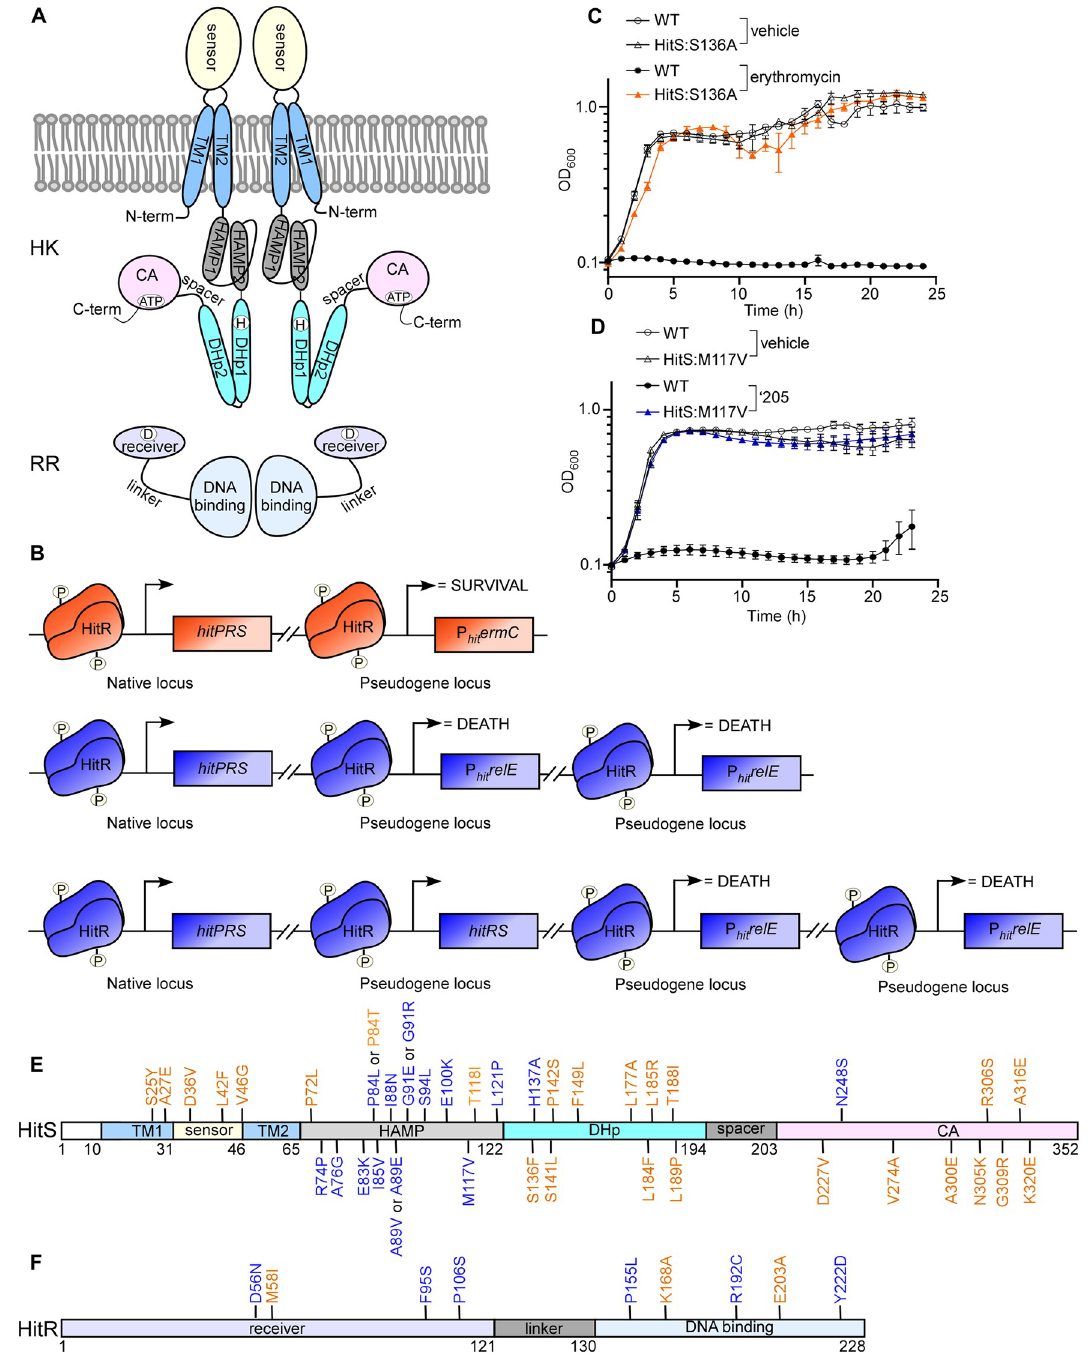
Fig 1. Genetic selection strategies to study HitRS signaling mechanism. (A) Schematics of the modular structure of a prototypical TCS. A classic histidine kinase (HK) consists of five domains: a N-terminal Trans-Membrane domain (TM), a sensor domain, a HAMP domain, a DHp domain, and a CA domain while a response regulator (RR) consists of two domains: a receiver domain and a DNA-binding domain. (B) Schematics for genetic selection strategies. To identify mutations that lead to constitutive activation of HitRS, an ermC strain shown in orange driven by a HitR promoter (P ) was used. The two strains shown in blue ( relE strains) were hit employed to isolate inactivating mutations within the TCS genes. (C) Growth kinetics of ermC expressing strains (WT and a representative ON mutant HitS S136A ) were monitored in the presence or absence of 20 μ g ml -1 of erythromycin. (D) Growth kinetics of relE expressing strains (WT and a representative OFF mutant HitS M117V ) were monitored in the presence or absence of 20 μ M ‘205. (E-F) Point mutations within HitS (E) and HitR (F) isolated from the genetic selections that lead to either inactivation (blue) or constitutive activation (orange) of this